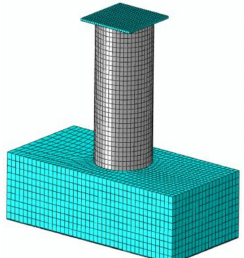
Figure 17. Finite element mesh of whole